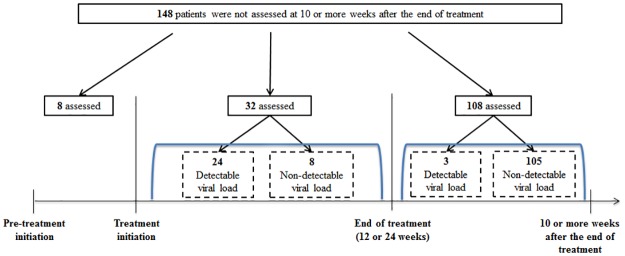
Results of last viral load among participants not assessed for SVR at 10 or more weeks after the end of treatment.Abbreviations: SVR, sustained virological response.